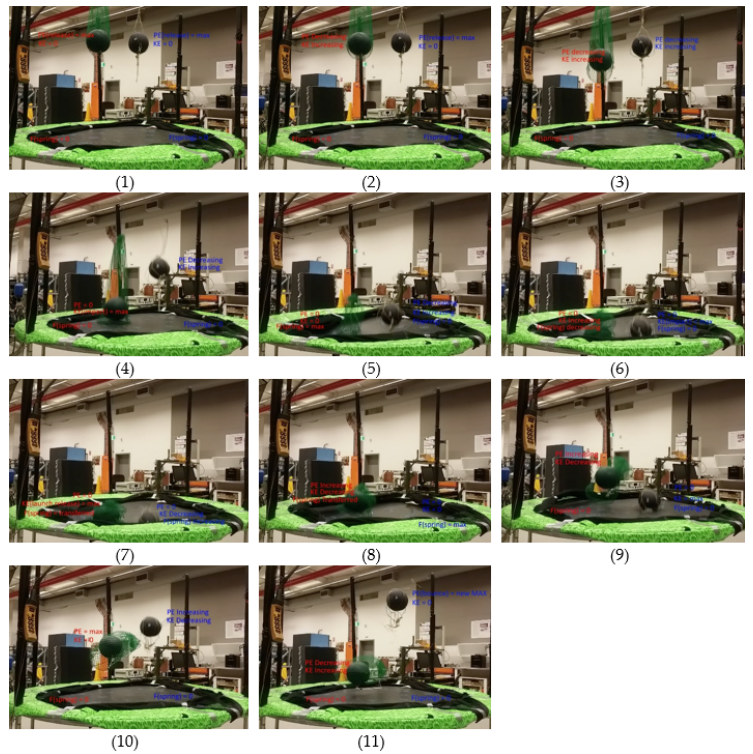
Figure 12. Double bounce process demonstration as recorded during experiment.